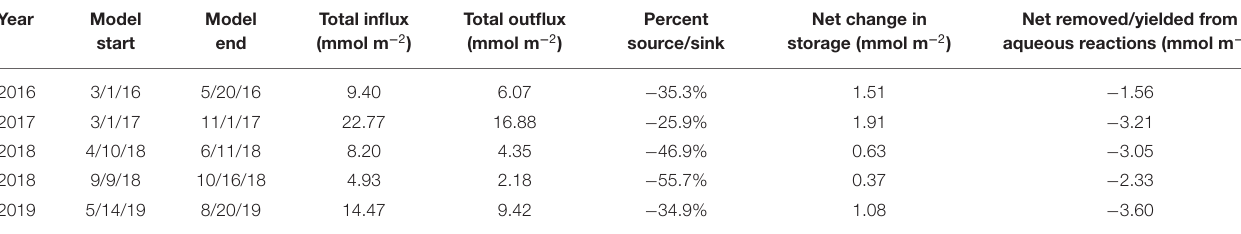
TABLE 2 | Cumulative NO − 3 mass balance values separated by year and relevant sub-period for which the model was run.